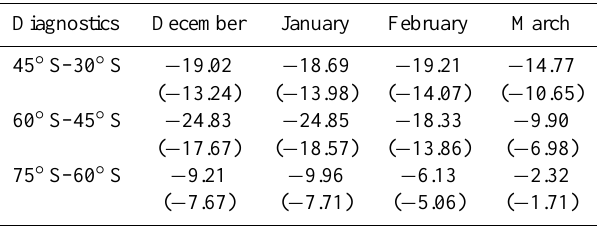
Table 5. Top of the atmosphere, all sky radiative forcing in control DMS emission (given in brackets) and double DMS emissions case over the latitudinal belts as given in the table during the SH summer